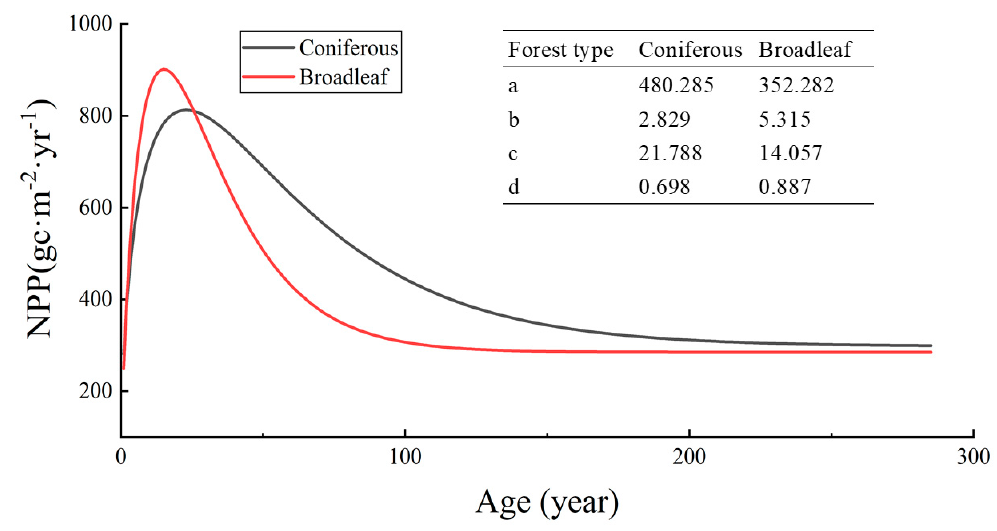
Figure 4. NPP – age relationship diagram and new parameters of coniferous forest and broadleaf forest in Zhejiang Province (a/b/c/d refer to Equation (1)).